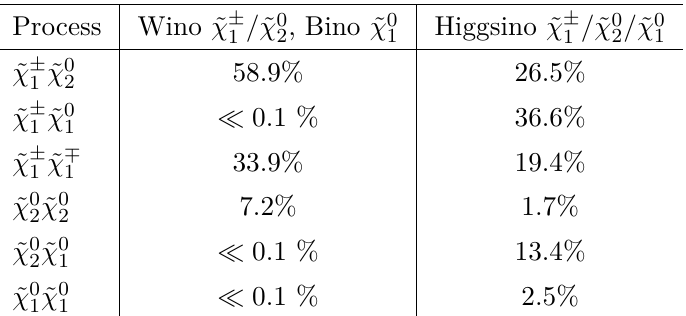
Table 2 . Chargino-neutralino contributions to the total VBF cross section. These values are obtained for a benchmark scenario with m (˜ χ 0